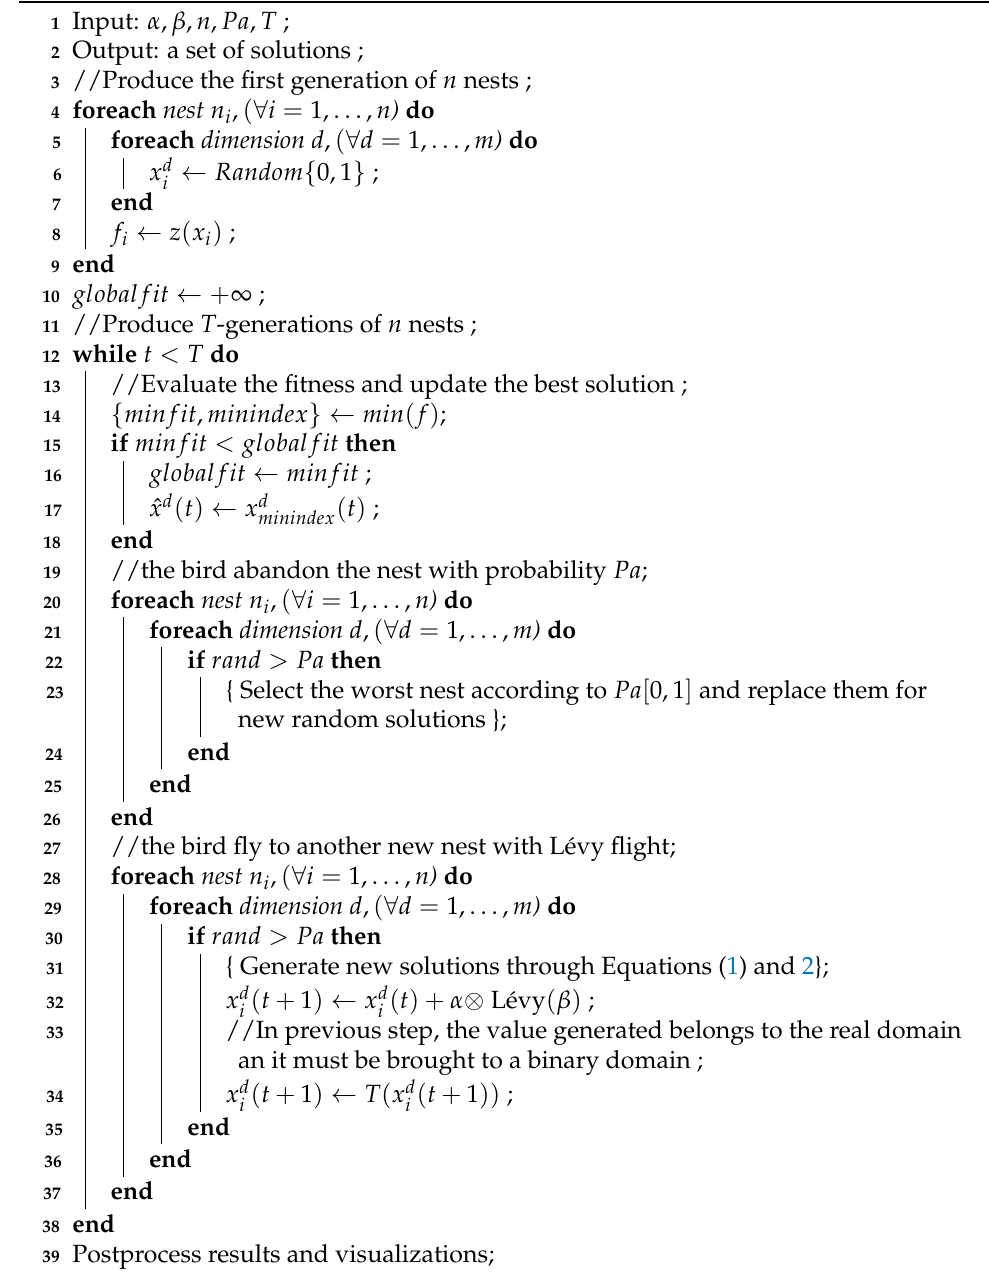
Algorithm 1: Cuckoo Search